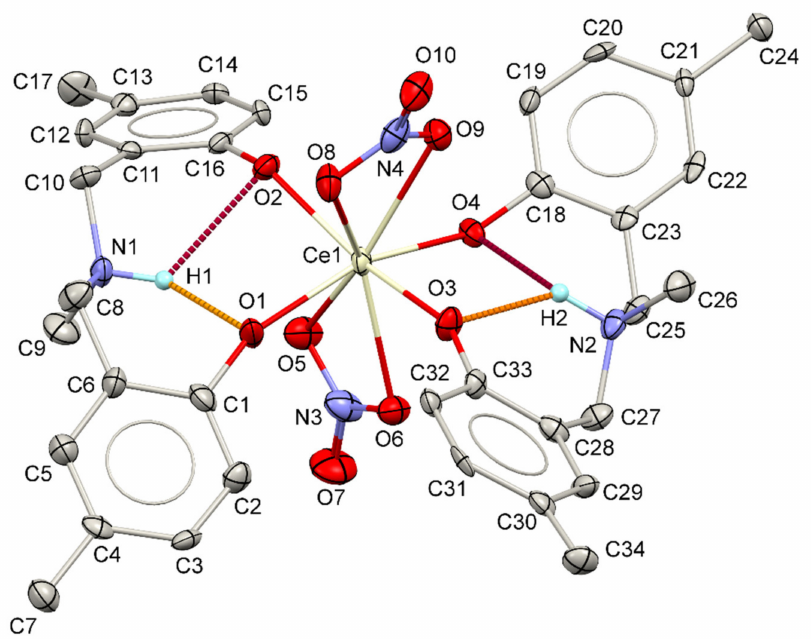
Figure 1. Molecular structure of the Ce-MMD complex including the non-IUPAC atomic labeling scheme. The displacement ellipsoids are drawn at the 50% probability level. The intramolecular N–H · · · O hydrogen bonds are shown as dark red and orange dash lines. Selected bond lengths (Å) and angles ( ◦ ): Ce1–O1 = 2.167(5) Å; Ce1–O2 = 2.208(5) Å; Ce1–O3 = 2.175(5) Å; Ce1–O4 = 2.161(5) Å; Ce1–O5 = 2.527(5) Å; Ce1–O6 = 2.531(5) Å; Ce1–O8 = 2.557(5) Å; Ce1–O9 = 2.532(5) Å; C8–N1–C9 = 112.4(6) ◦ ; C8–N1–C10 = 113.1(6) ◦ ; C9–N1–C10 = 111.2(6) ◦ ; C25–N2–C26 = 111.6(6) ◦ ; C25–N2–C27 = 113.3(6) ◦ ; C26–N2–C27 = 110.9(6) ◦ .